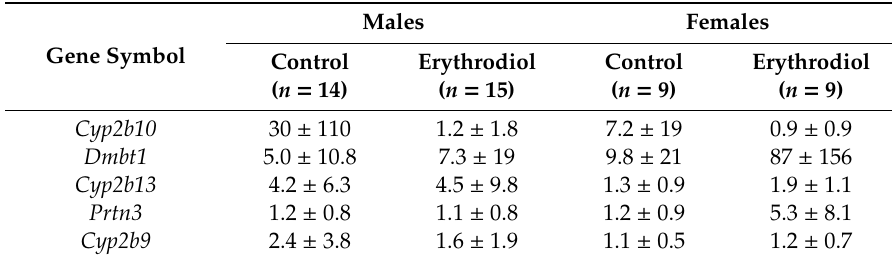
Table 6. E ff ect of 10 mg / kg erythrodiol on selected gene expressions in Apoa1 -deficient mice according to sex. Males Gene Symbol